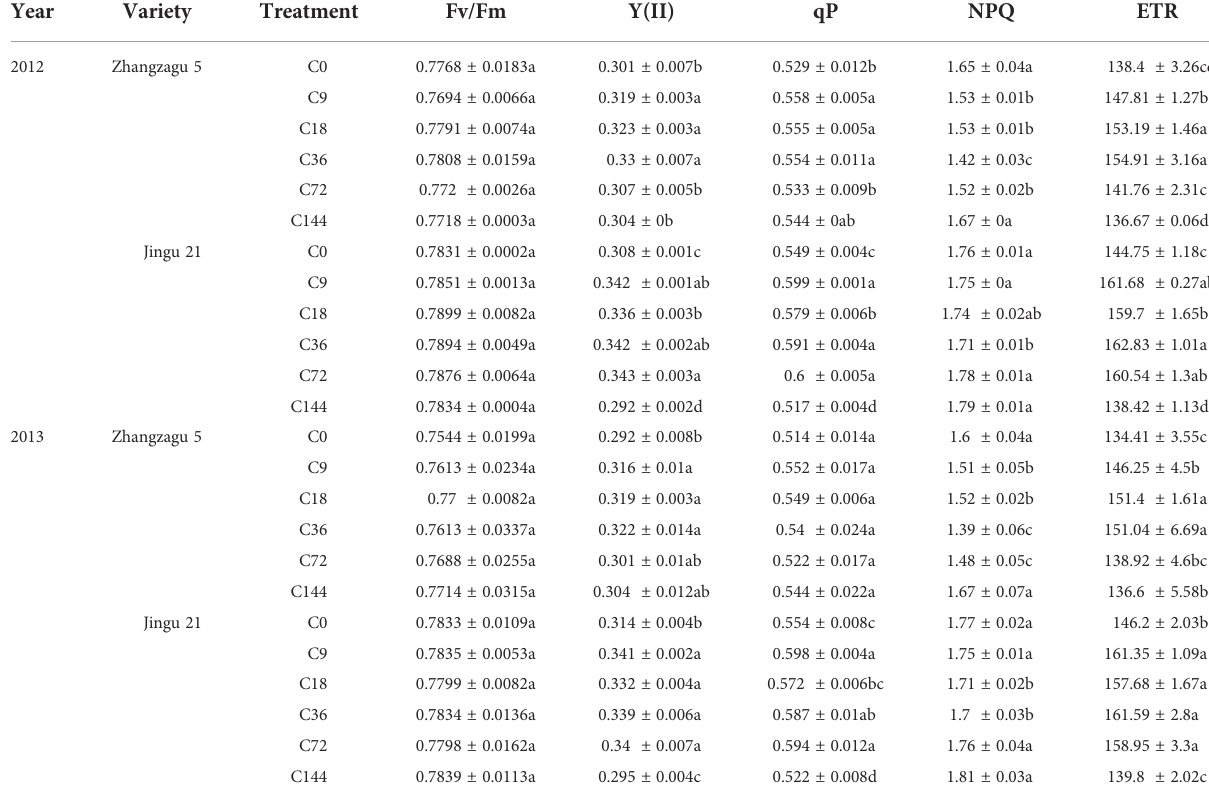
TABLE 3 Effects of naphthalene acetic acid on chlorophyll fl uorescence in leaves of foxtail